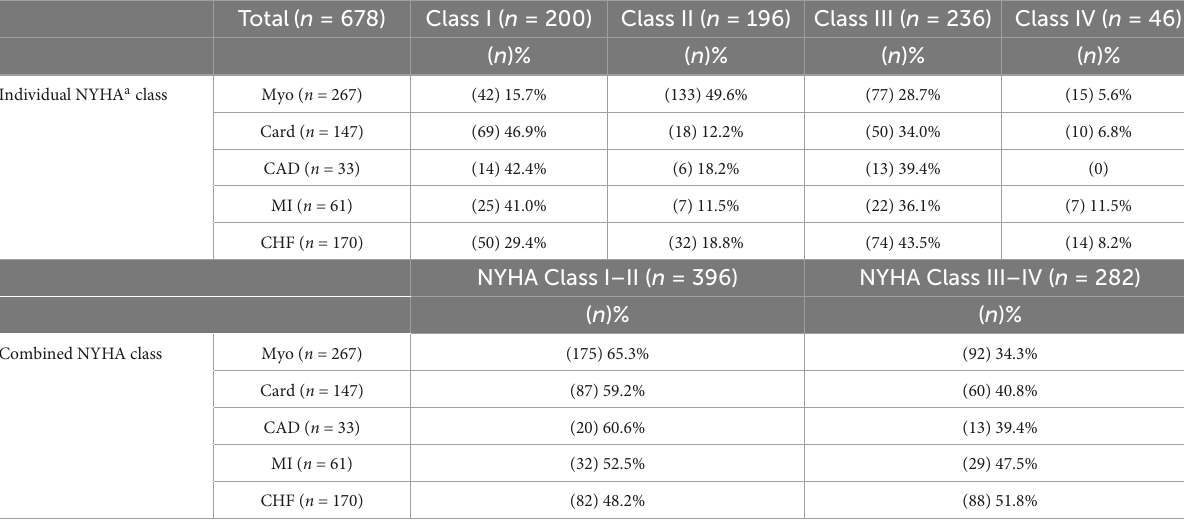
TABLE 3 NYHA class in patients with CVDs ( n =